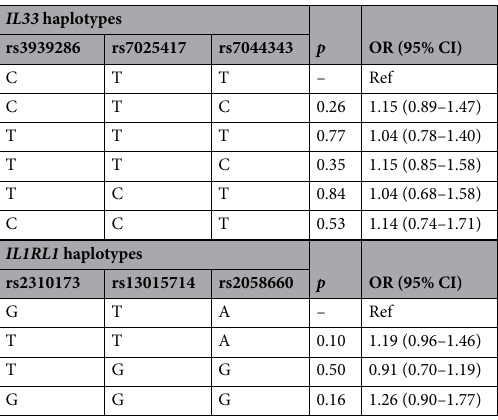
Table 4. Haplotype analysis of IL33 and IL1RL1 genes between patients with IgAV and healthy controls. IgAV: IgA vasculitis; OR: Odds Ratio; CI: confidence interval. Haplotypes of IL33 and IL1RL1 with a frequency higher than 5% are